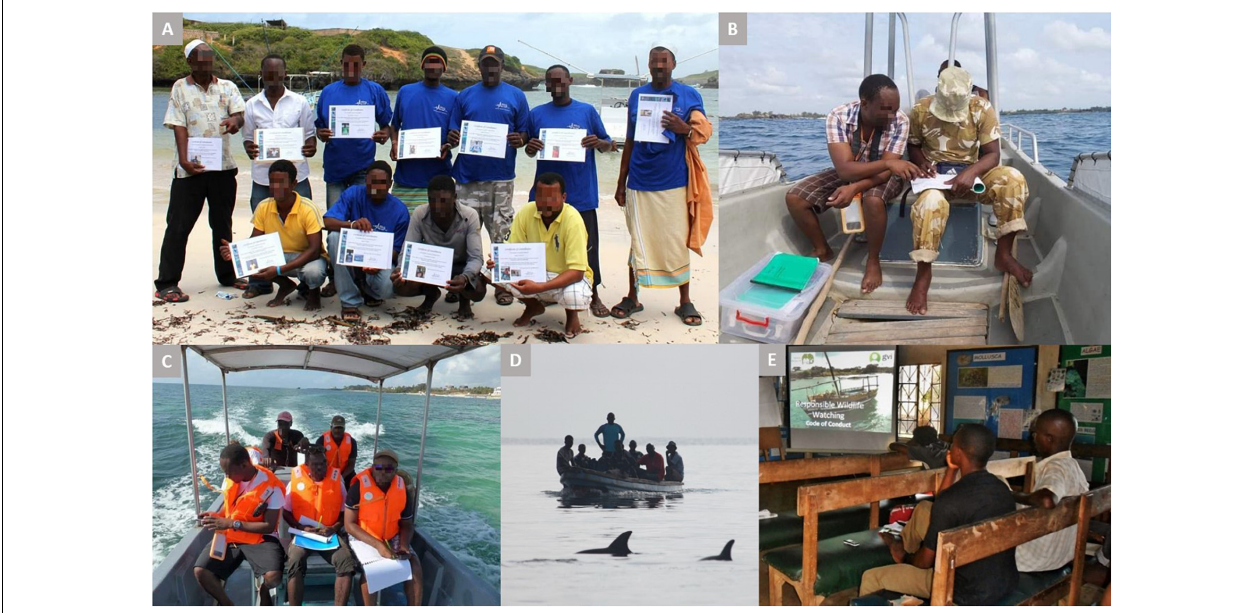
FIGURE 2 | Marine users. (A) Fishermen and tour operators from Watamu receive certificates from WMA after completing a training in marine mammal identification and sustainable whale watching practices (2013). (B,C) WMA training KWS in marine mammal boat based surveys in Malindi Marine Park (2018, 2019). (D) Indo-Pacific bottlenose dolphin sighting reported by South Coast MUs (2012). (E) Workshop on species identification and eco-tourism for tour operators in the Kisite-Mpunguti Marine Protected Area